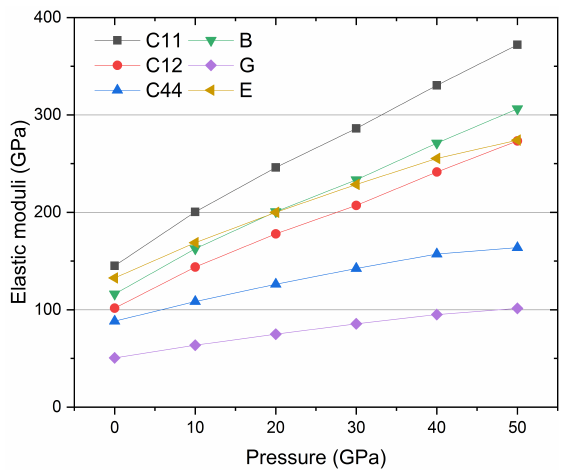
Figure 8. The elastic constants C ij , bulk modulus B, shear modulus G and Young’s modulus E of Ti 2 NiIn compound under different